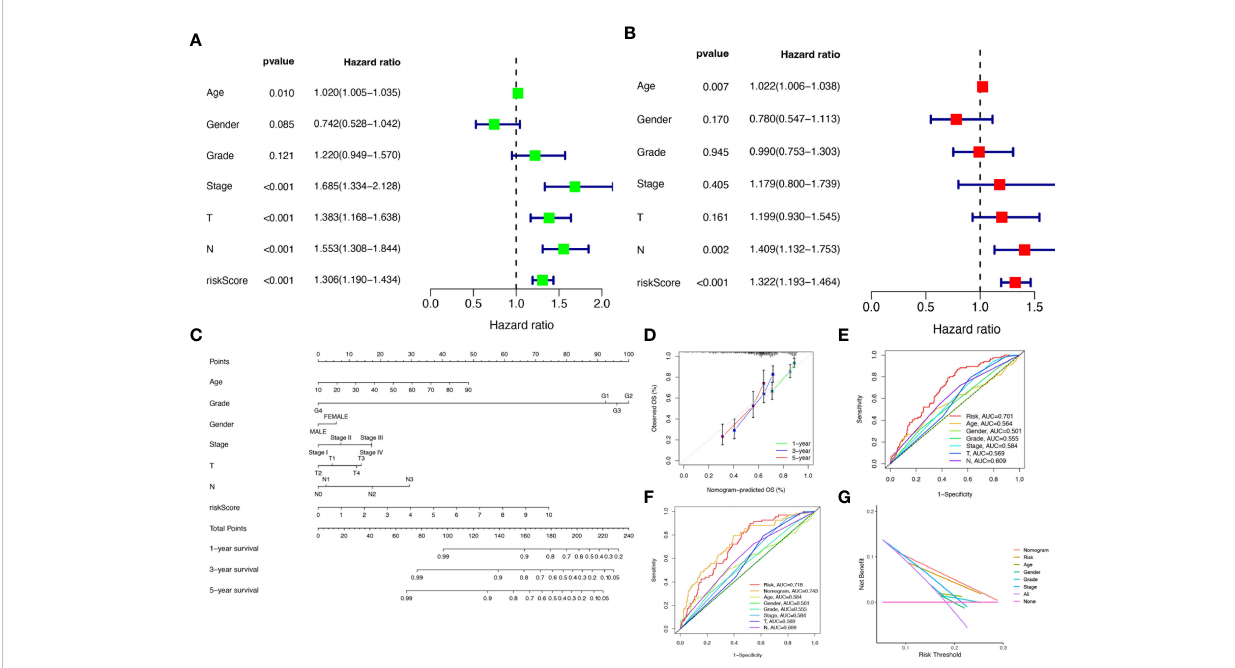
FIGURE 6 Creation of nomograms based on 6-CRRGs signatures combined with clinical characteristics. (A) Univariate and (B) multivariate COX regression analysis of the signature and different clinical features. (C) A nomogram combining risk score, age, grade, gender, stage, T stage, and N stage. (D) The calibration curve of the constructed nomogram of 1-year, 3-year, and 5-year survival. (E) Time-dependent ROC curves analysis. (F) The nomogram ’ s time-dependent ROC curves. (G) Decision curve